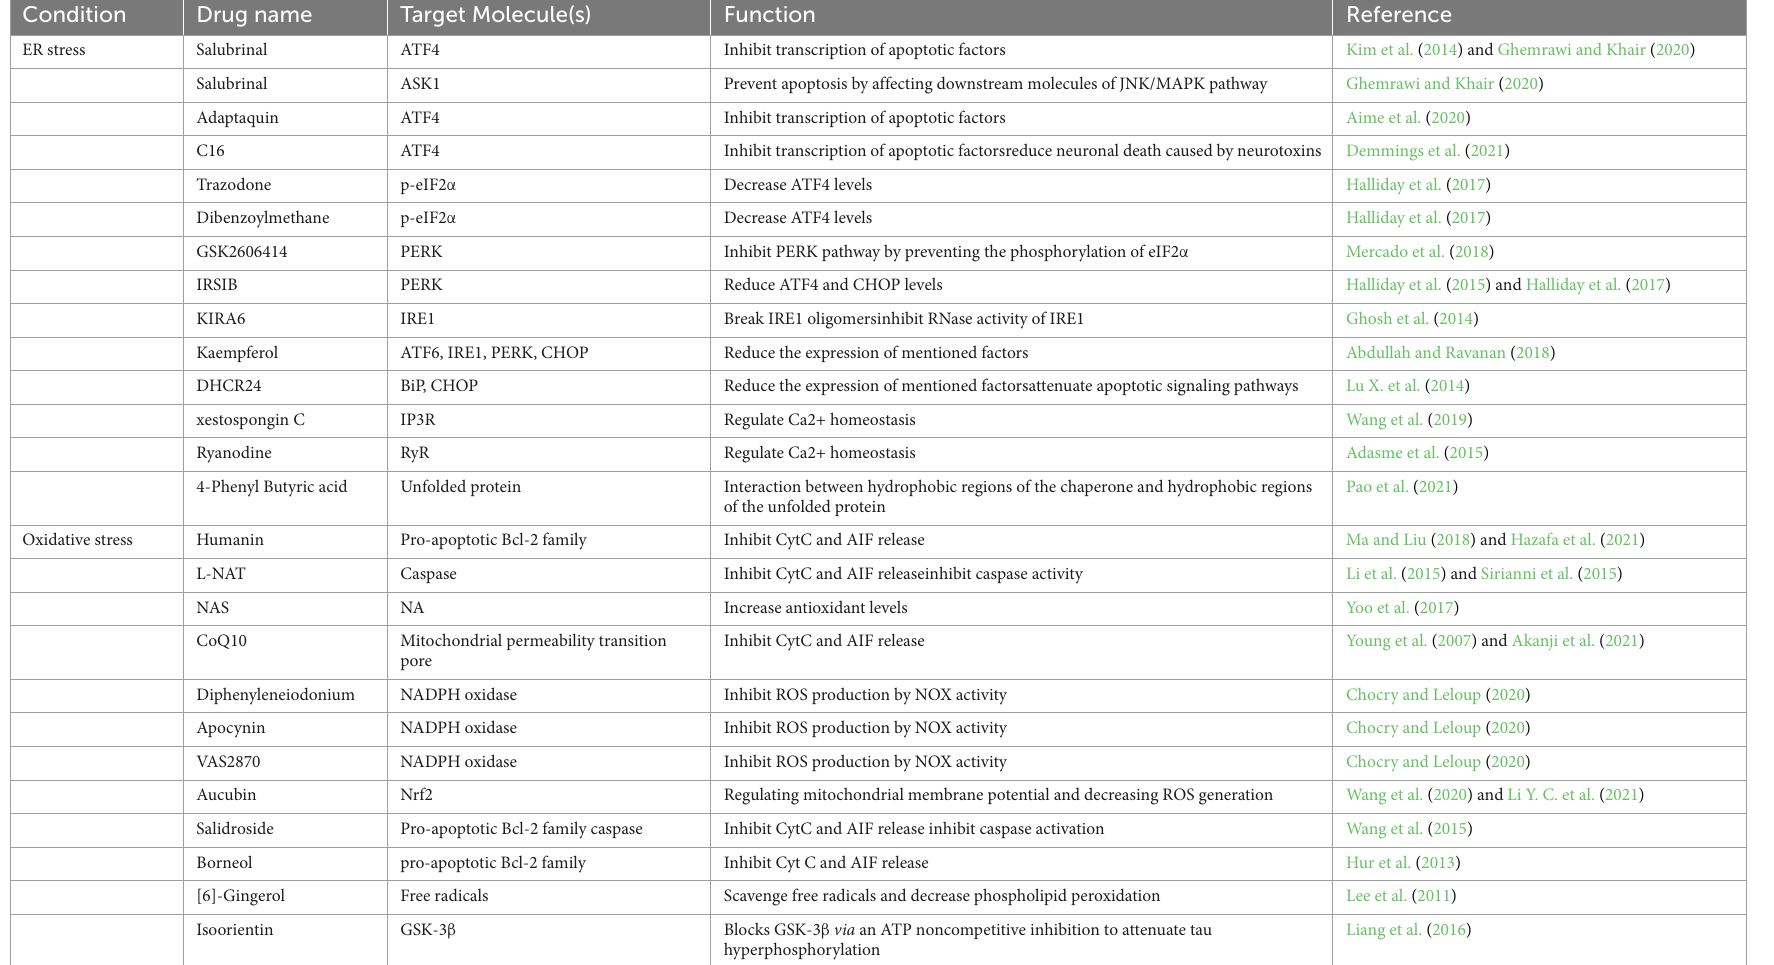
TABLE 2 The function and target molecules of drugs tested in neurodegenerative disease models in different cellular stress